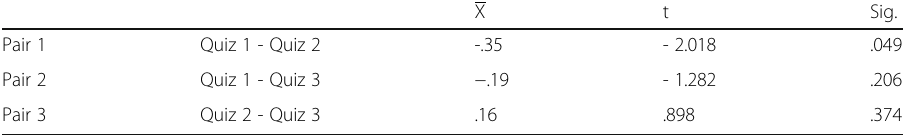
Table 8 EFL learners ’ IC - Formative test (Paired differences- Paired samples t-test) X t